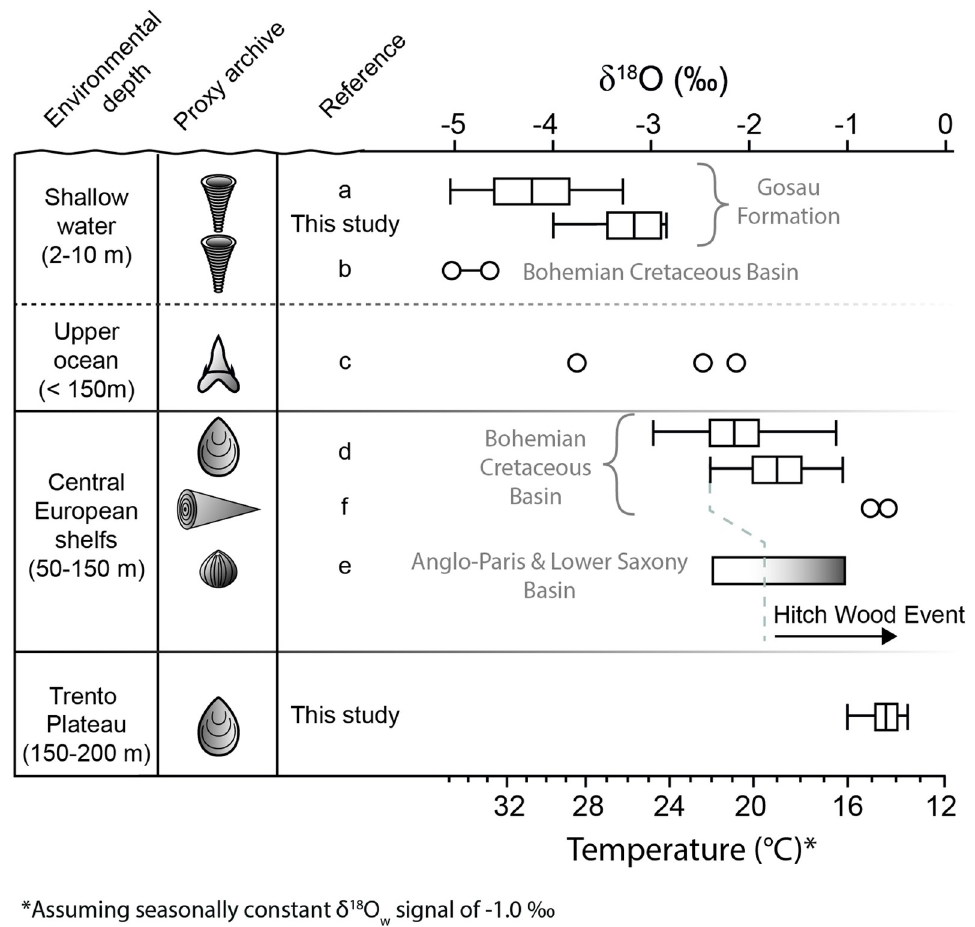
Fig 5. The reconstructed vertical temperature gradient at the northwestern margin of the Tethyan Ocean. Values were compiled from novel and published data. Seasonally resolved temperature estimates are shown as box plots, whereas temperature ranges are shown as bars. Dots represent the temperature estimates based on single δ 18 O values. Temperature estimates for the shallow and upper ocean waters derived from stable oxygen isotope data of (a-b) rudist shells [22,65,84]and (c) shark teeth [21]. Temperature information for deeper environments were derived from (d) inoceramid [55] and (e) brachiopod shells [12] as well as from a (f) belemnite rostrum [85]. The Hitch Wood Event represents the coldest interval of the late Turonian. Temperatures were computed assuming an average ocean δ 18 O water value of -1.00 ‰ [81].